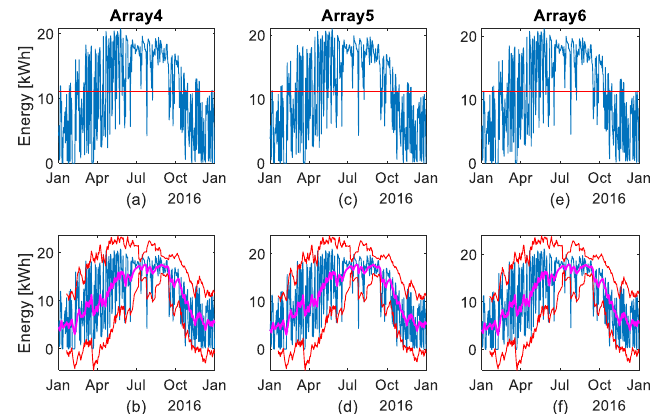
Figure 9. ( a ) Energy produced by array #1 in twelve months and its mean value as red line; ( b ) upper and lower BB 20 of array #1 in red color, and EMA 20 in magenta color. ( c ) and ( d ) refer to array #2. ( e ) and ( f ) refer to array #3.